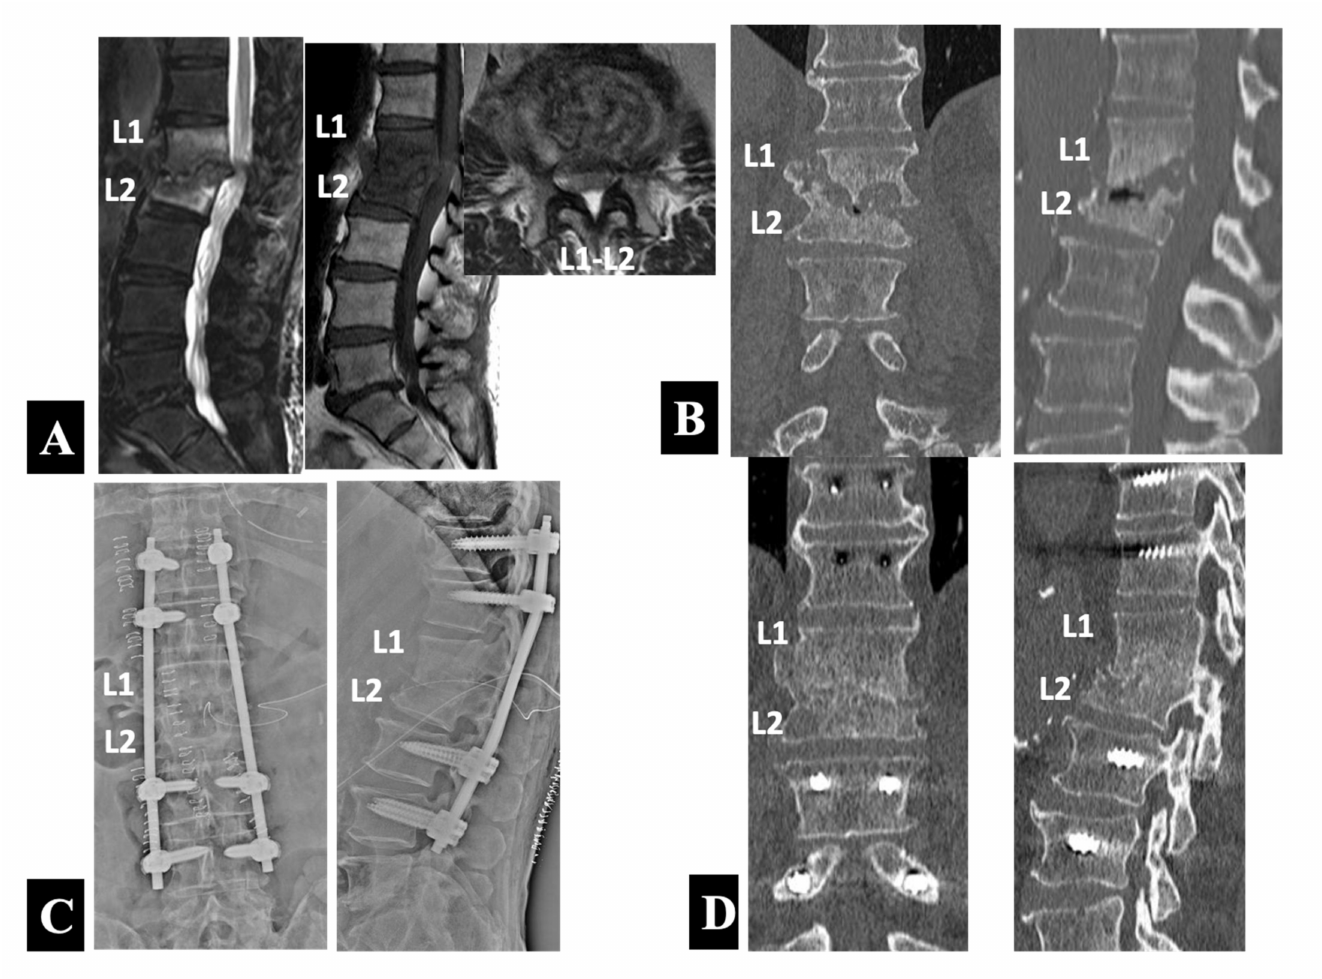
Figure 4. Preoperative sagittal T2- and sagittal and axial T1-weighted MRIs ( A ) and coronal and sagittal reformatted CT images ( B ) in a 77 year old neurologically compromised man with relapsed pyogenic spondylodiscitis at L1 and L2. He underwent a single-stage operation with PPS–rod fixation at the unaffected vertebrae of the T11 and T12 rostrally and the L3 and L4 caudally followed by posterior exposure for decompression and debridement at L1–L2 (Group 2-A) as shown by postoperative anteroposterior and lateral plain radiographs taken immediately after surgery ( C ) and coronal and sagittal reformatted CT images 1 year postoperatively ( D